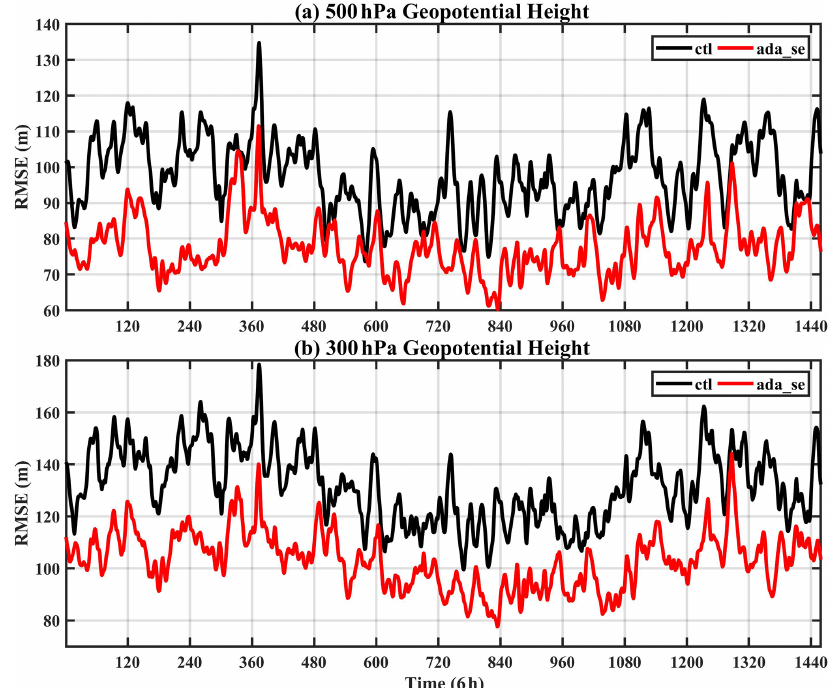
Figure 9. Time series of RMSEs of (a) 500hPa geopotential and (b) 300hPa geopotential from ctl (black lines) and ada_se (red lines).